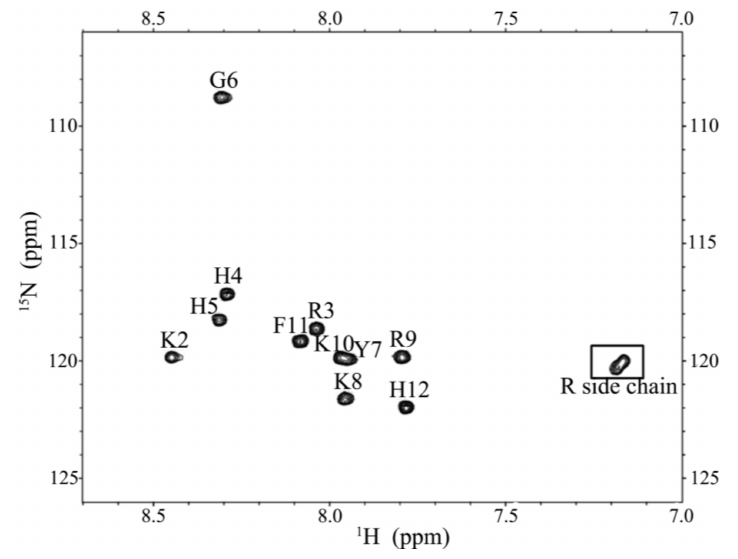
Figure 7. 1 H- 15 N HSQC of P-113 in SDS micelles. Cross-peaks are labeled according to the residue types and